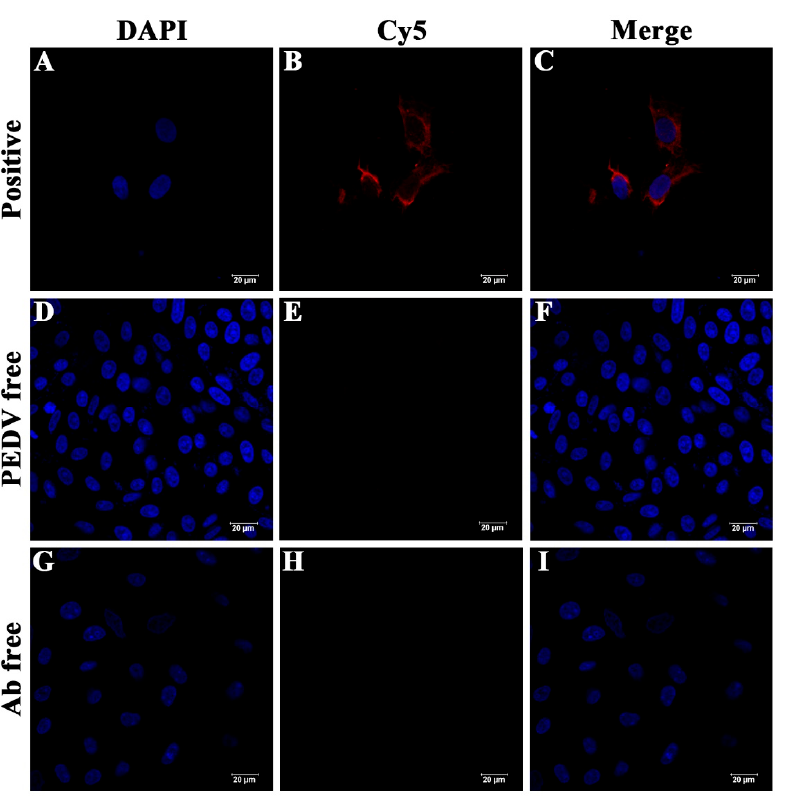
Figure 3. Cell immunofluorescence analysis of anti-PEDV antibody. ( A – C ): PEDV-positive and antibody-positive group: PEDV-infected Vero cells were incubated with anti-PEDV antibodies; ( D – F ): PEDV-negative and antibody-positive group: uninfected Vero cells were incubated with anti- PEDV antibodies; ( G – I ): PEDV-positive and antibody-negative group: PEDV-infected Vero cells were incubated with negative serum of unimmunized mice. Subsequently, all three groups were incubated with goat anti-mouse IgG (Alexa Fluor ® 647). Microscopic images showing that goat anti-mouse IgG (Alexa Fluor ® 647) only had reactions with PEDV-positive and antibody-positive group. Blue: DAPI-stained DNA; red: Goat anti-mouse